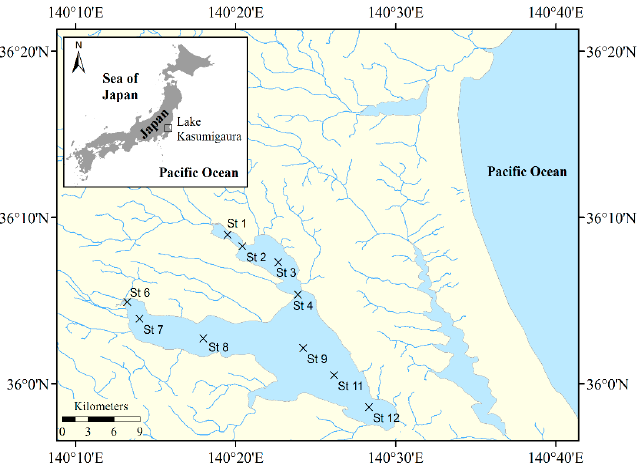
Figure 1. Distribution of the sampling sites at Lake Kasumigaura, as defined by the National Institute for Environmental Studies (NIES).